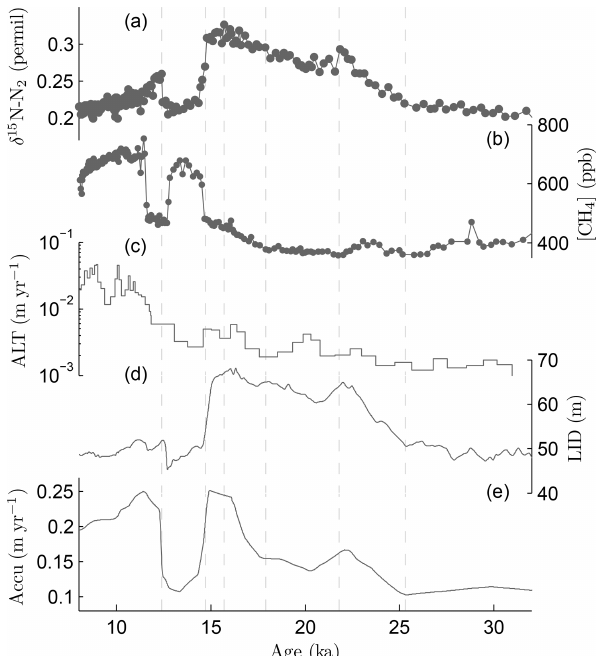
Figure 8. Comparison of (a) δ 15 N-N 2 , (b) CH 4 , (c) annual layer thickness implied from depth–age scale, (d) lock-in depth (LID), and (e) accumulation reconstructions from the RICE ice core. Lock- in depth and accumulation are calculated with a dynamic Herron– Langway firn densification model.